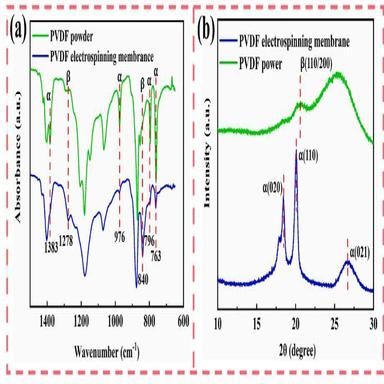
(a) XRD patterns and (b) FTIR patterns of PVDF raw powder as well as PVDF electrospinning membrane.